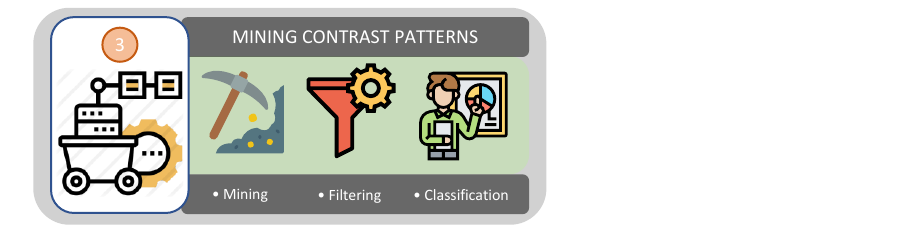
Figure 4. The extraction of the contrast patterns consist on three phases mining, filtering and classifi-